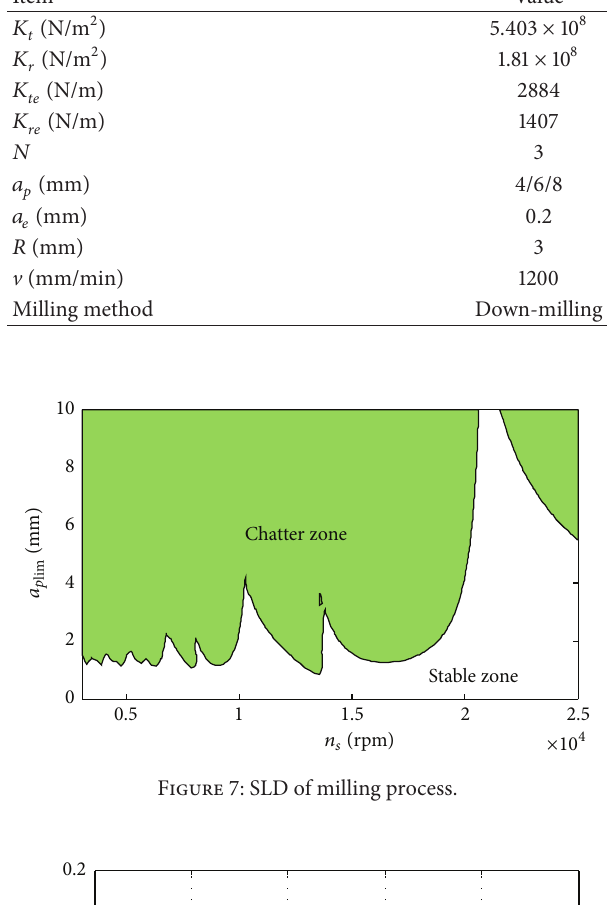
are time-varying; the corresponding values are